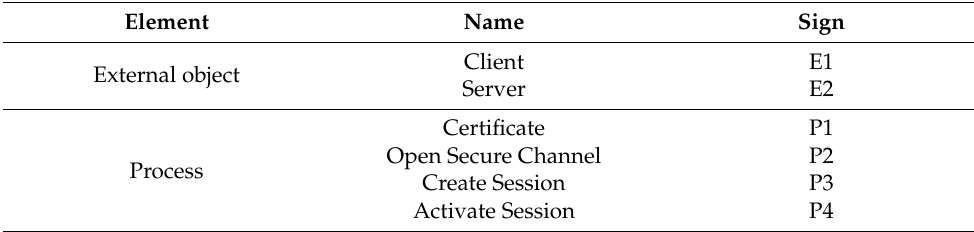
Figure 10. Configuration diagram for the scenario.